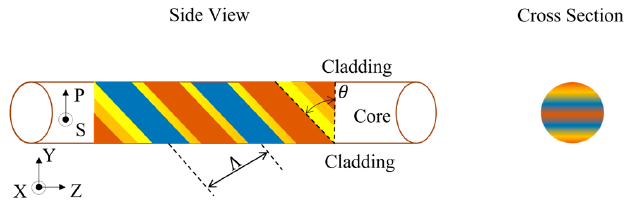
Figure 1. Side and cross-section views of the index perturbation modes caused by the tilted gratings in an optical fiber.